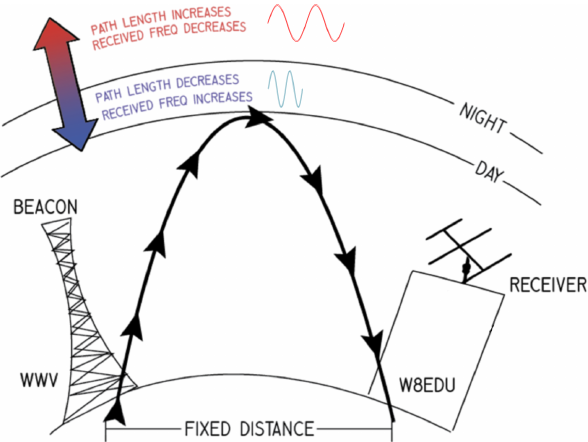
Figure 1. A simplified illustration of the relationship between rate of change in ionospheric layer height and received frequency shift. Precision frequency standards are required at both beacon and re- ceiver in order to make an effective comparison. Frequency varia- tion is generally on the order of ± 1Hz. Multihop propagation (mul- tiple reflections between ionosphere and ground), Pedersen modes (internal ionospheric reflections), asymmetric paths, and other fac- tors impacting path length are not shown. Reproduced from Collins et al.